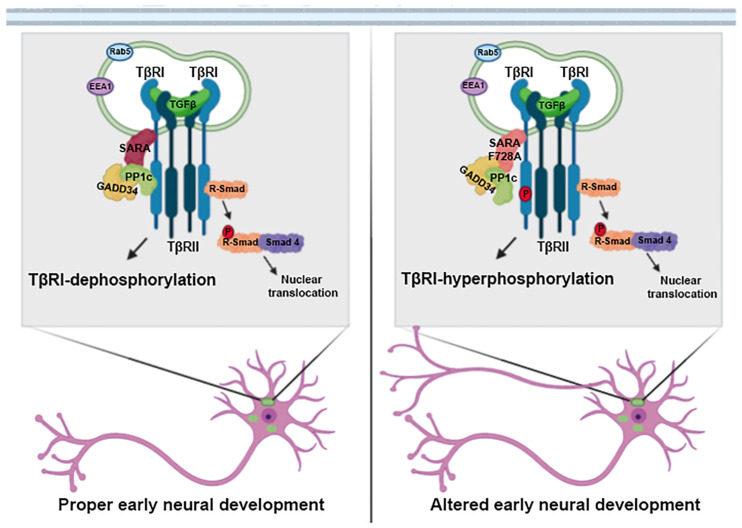
SARA is a negative regulator of the TGFβ pathway during early neuronal development. Schematic representation of the working model. SARA basally controls the deactivation of TβRI through the recruitment of the inhibitory complex PP1c/GADD34 in the endosomes of polarizing neurons. The loss of function of SARA by the dominant-negative SARA-F728A mutant, overactivated the TGFβ pathway. This functionally impacts neuronal development, promoting axonal growth, and cortical migration of neurons during brain development.